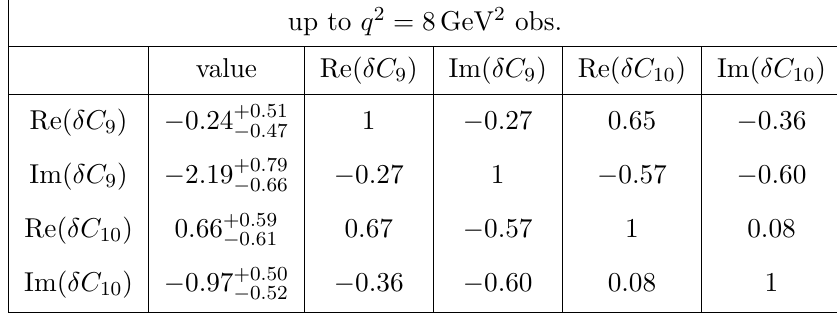
Table 6 . Fit results and correlation coe(cid:14)cients for (cid:14)C 9 and (cid:14)C 10 using observables up to q 2 = 8 GeV 2 .